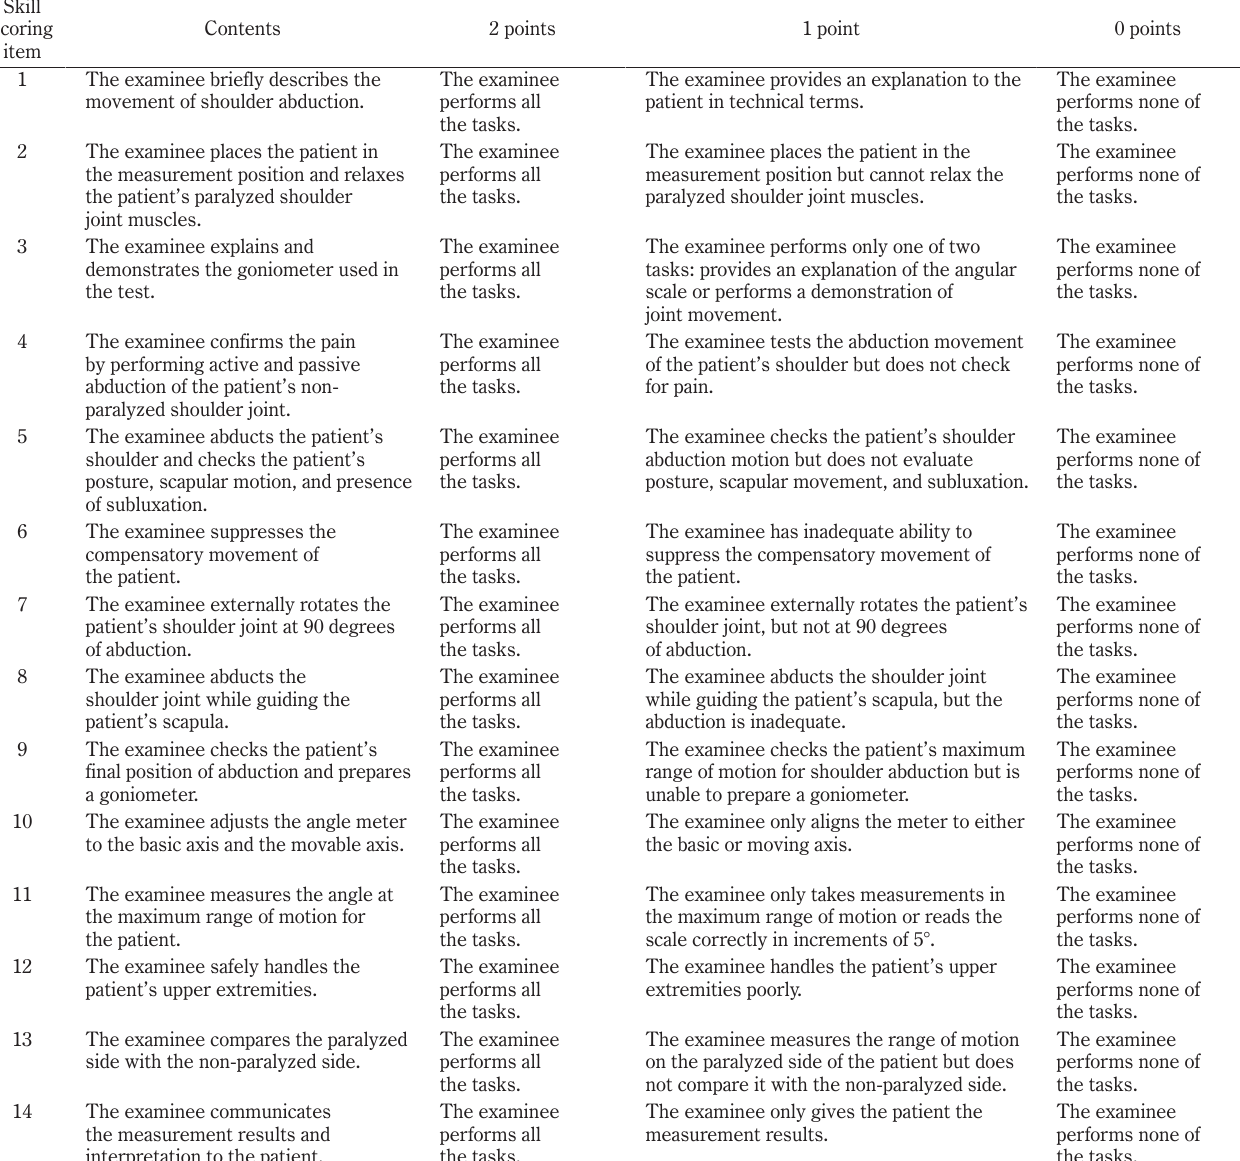
Table 1 Scoring rubric for objective structured clinical